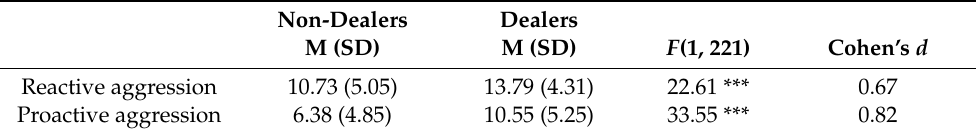
Table 2. Reactive and Proactive Aggression Used by Non-Dealers (N = 79) and Dealers ( N = 147).